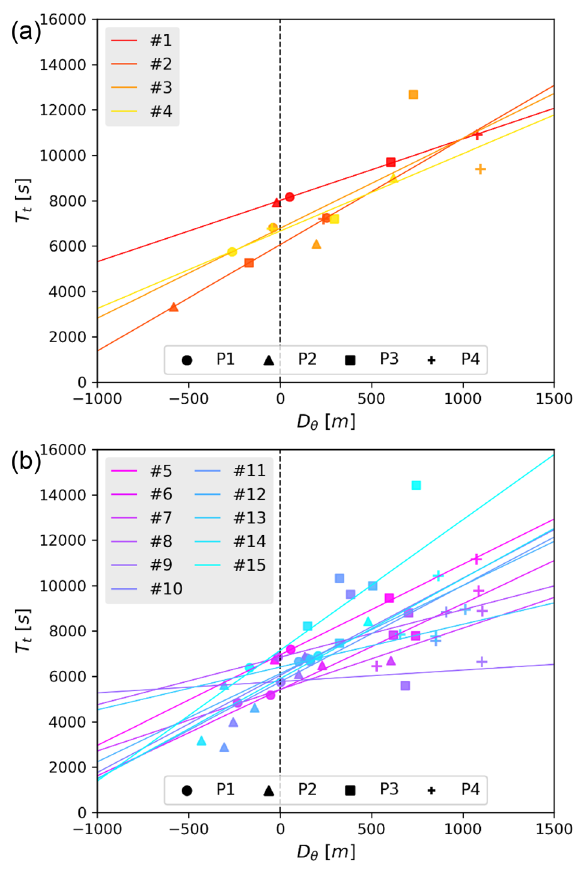
with correlation coefficient > 0.7. ( a ) Events with a coefficient > 0.8 and ( b ) with a coefficient between 0.7 and